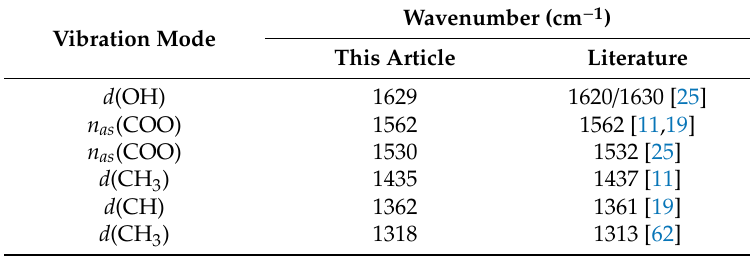
Table 5. Assignment of FTIR bands observed for commercial titania samples (P25, P90,